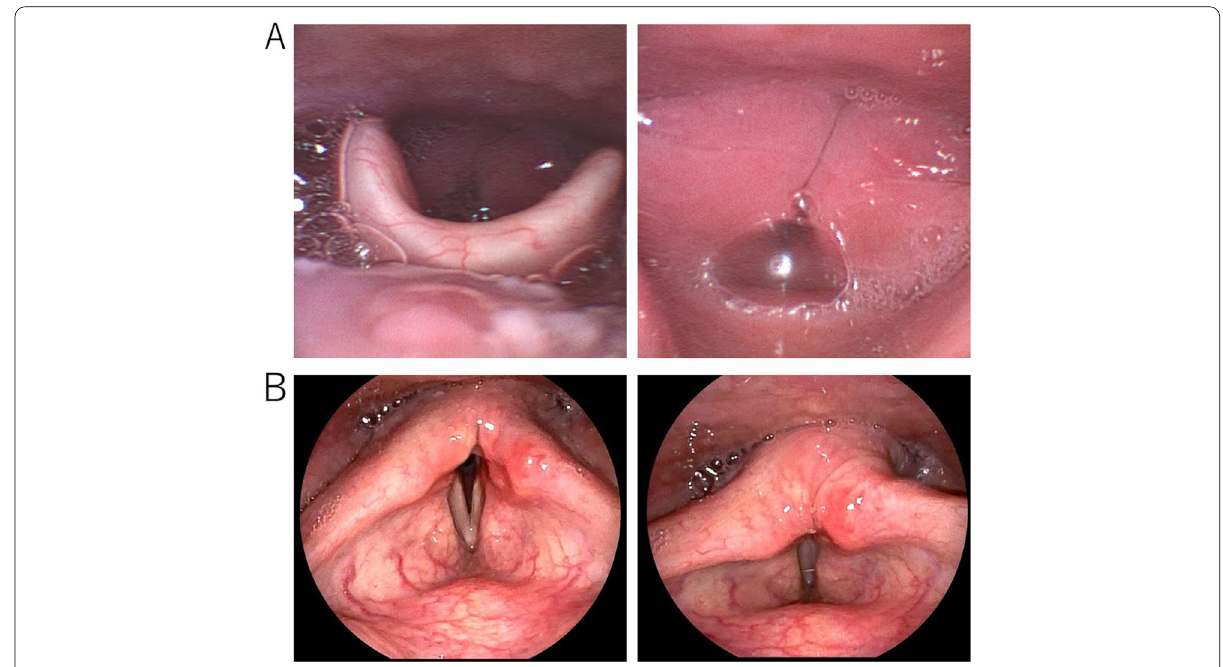
Fig. 2 The finding of a pharyngeal fiberscope. A Six days after the extubation. B Six days after the